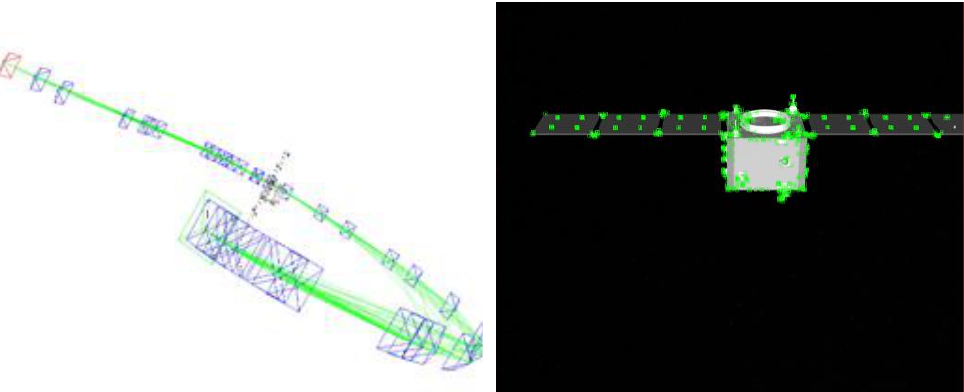
Figure 16. Visualization of pose information and image with feature points extracted in the